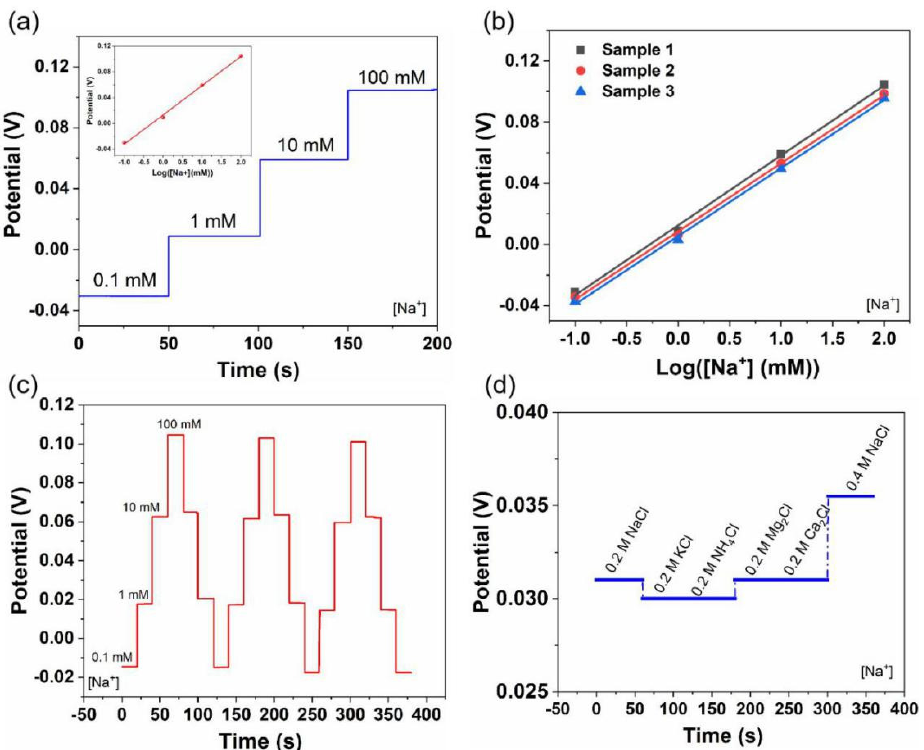
Figure 3. Na + -sensing performance of flexible LIG-based sensors: ( a ) sensitivity, ( b ) reproducibility, ( c ) stability, and ( d ) selectivity. Inset in ( a ) is the corresponding calibration plot.